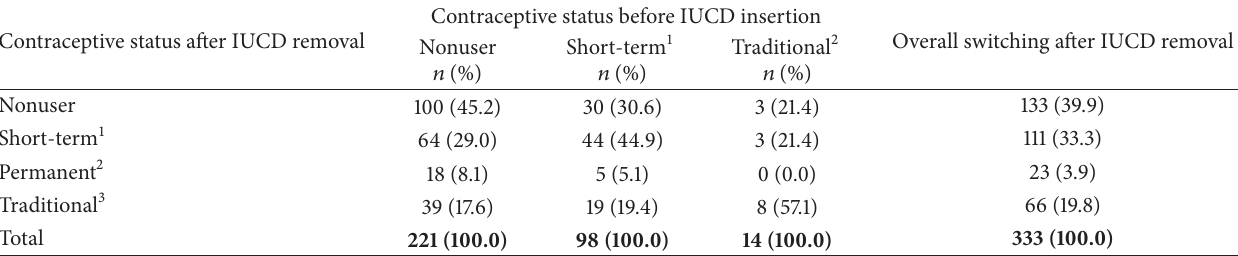
Table 2: Method switching behavior among women who had IUCD